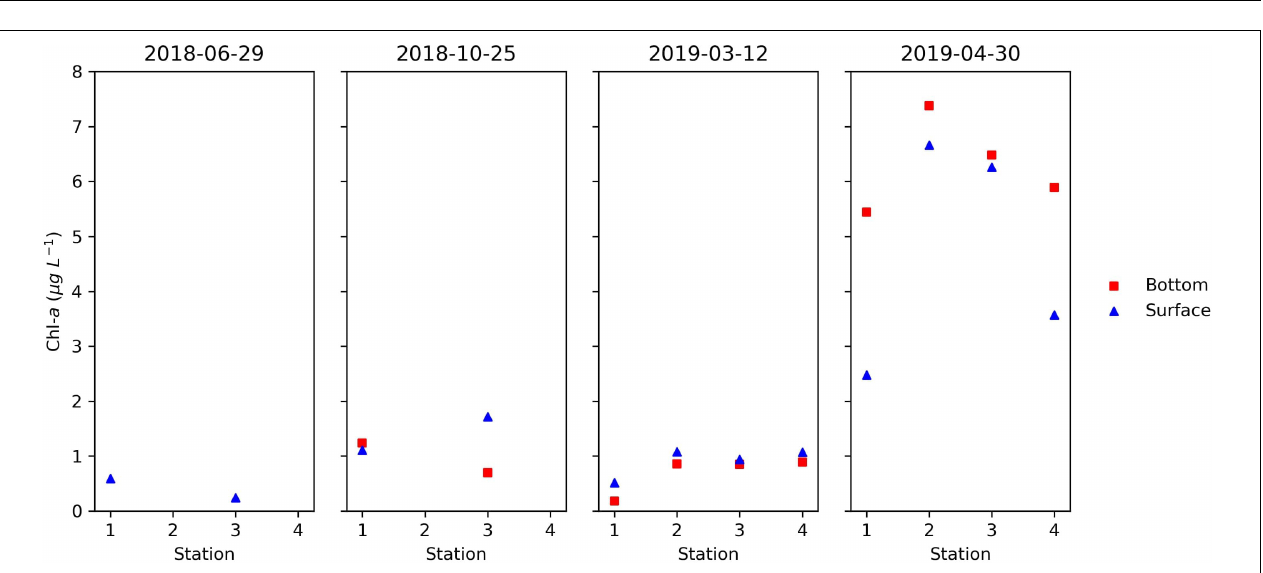
FIGURE 4 | Total Chl- a in µ g L - 1 , at the surface (top) and bottom (down) of the four sampling stations on 2018-06-29, 2018-10-25, 2019-03-12, and 2019-04-30. In June 2018, only stations 1 and 3 were sampled on the surface. In October 2018, only stations 1 and 3 were